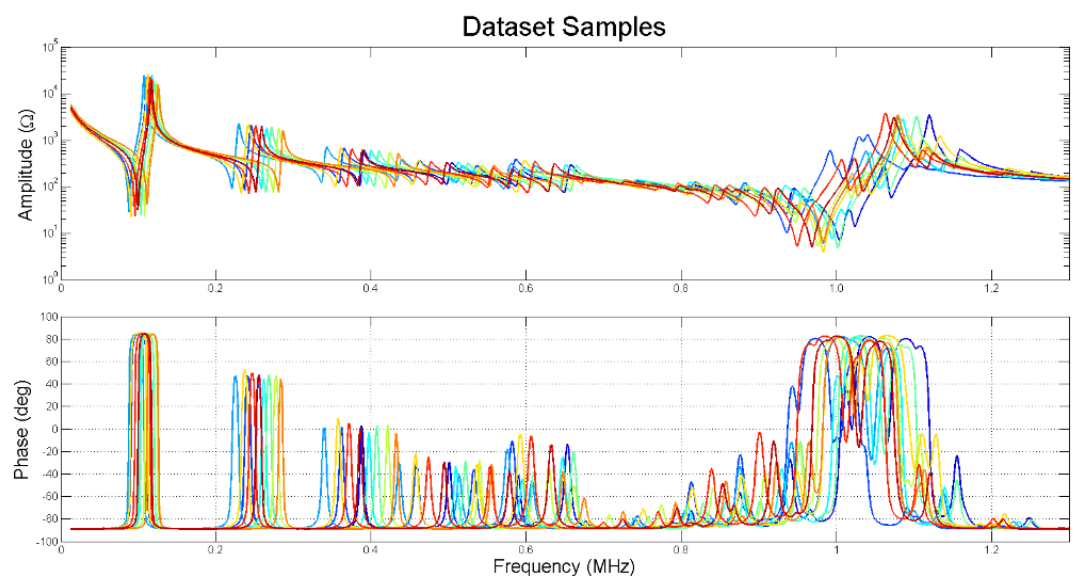
Figure 4. Impedance curves for 10 samples randomly picked in the dataset.